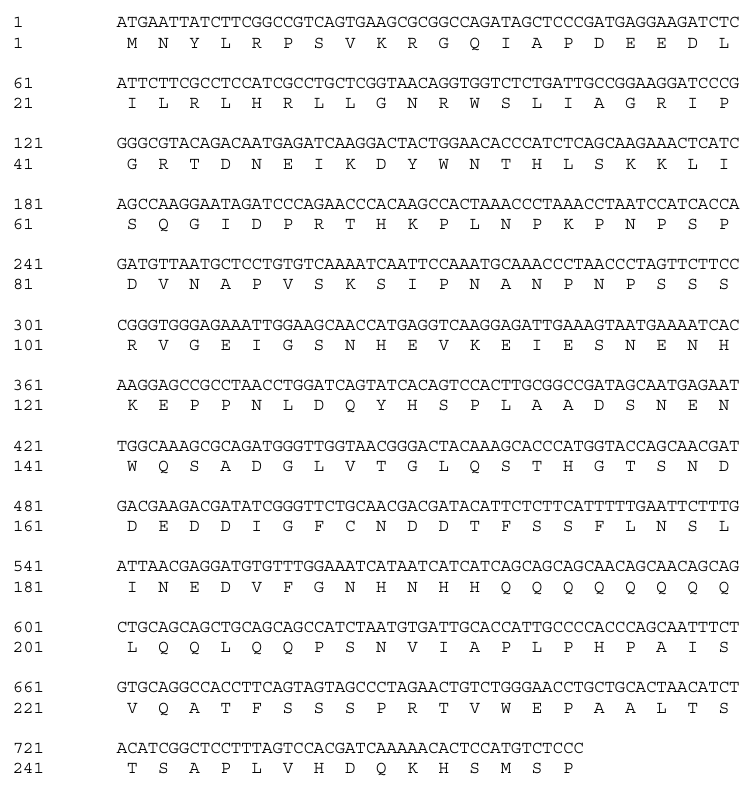
Figure 2. The complete cDNA sequence and amino acid sequence of the protein encoded by MYBCS1 (GenBank accession number: KJ513438).